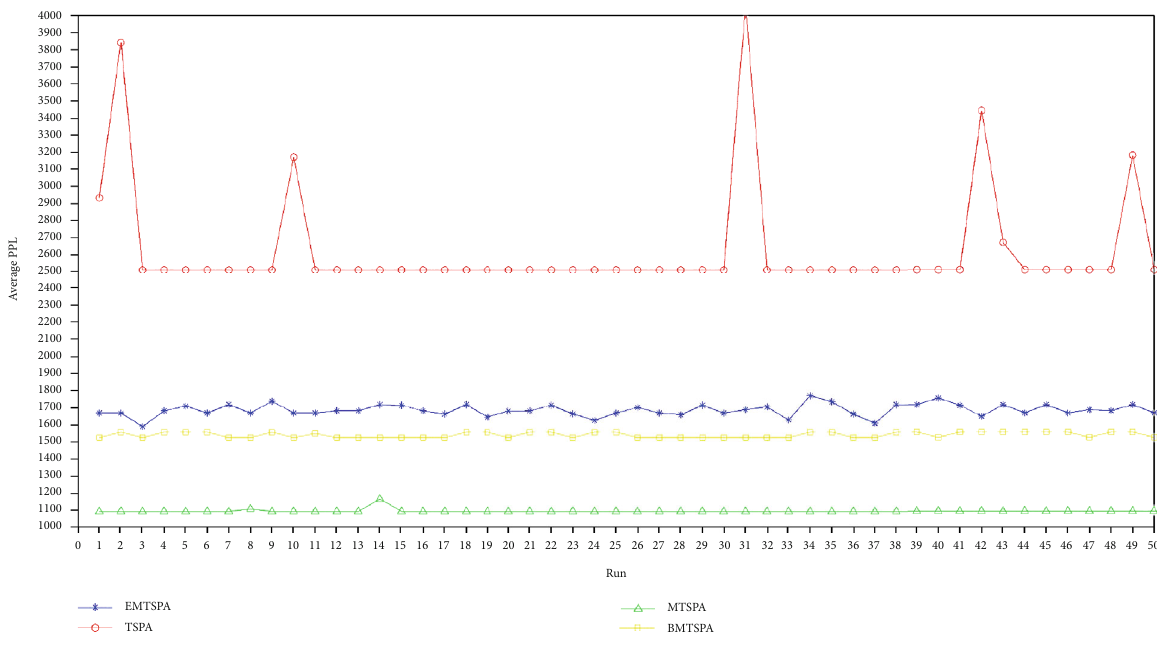
Figure 8: Average PPL in 50 rounds of